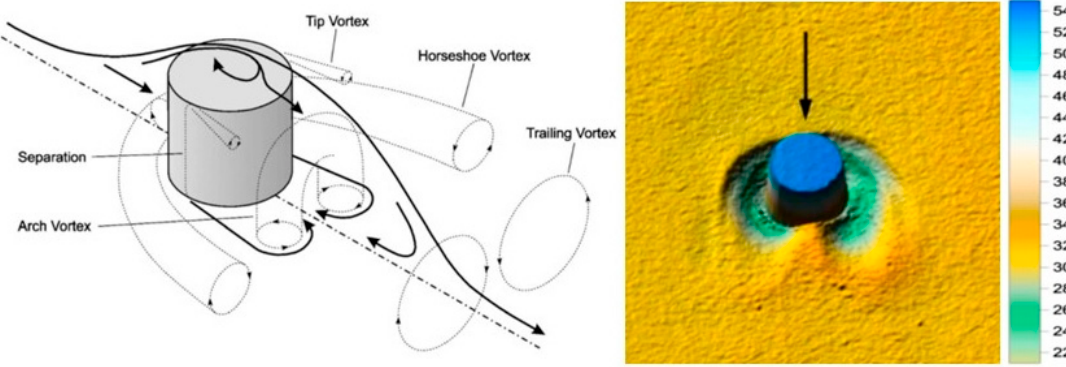
Figure 1. ( Left ) Conceptualization of coherent flow structures surrounding a wall-mounted cylinder (Reproduced from McKenna Neuman and Bédard [15] p. 1827, originally from Pattenden et al. [29]). Copyright 2005, with permission from Springer Nature. ( Right ) Resulting morphology after a transporting event with height scale in mm (Reproduced from McKenna Neuman and Bédard [15] p. 1829). Copyright 2015, with permission from John Wiley and Sons.